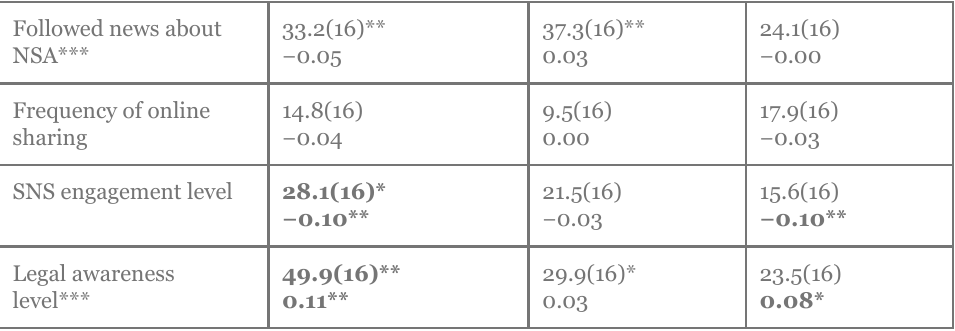
Table 4 − Online surveillance by a private internet company (#4): chi-square ( Χ 2) and gamma (γ) test results predicting respondents being more careful in their online speech and searches after made aware of online surveillance by a private internet corporation More cautious/careful in More cautious/careful in online speech